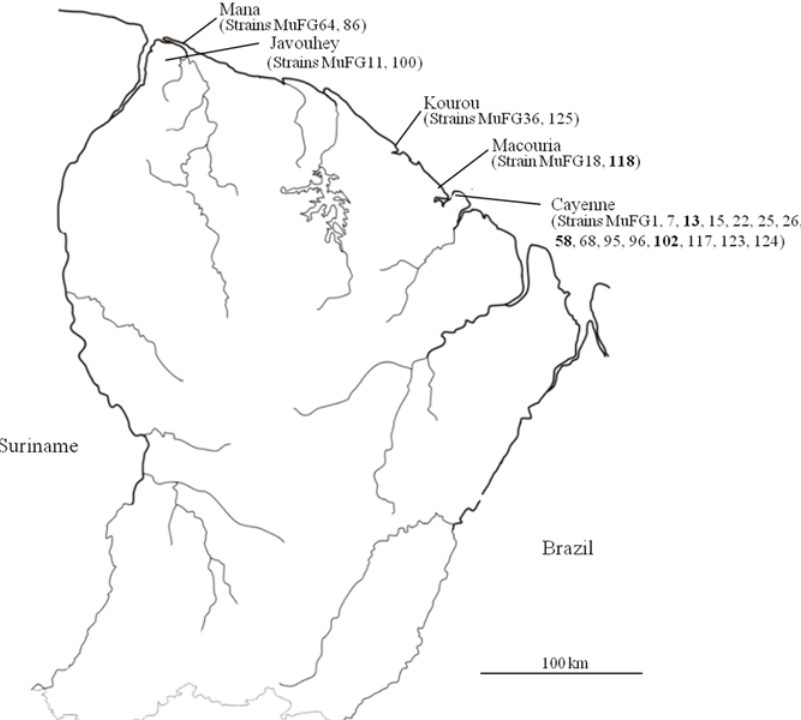
Fig 4. Localization of M . ulcerans samples in French Guiana. In bold isolates belonging to genotype II.